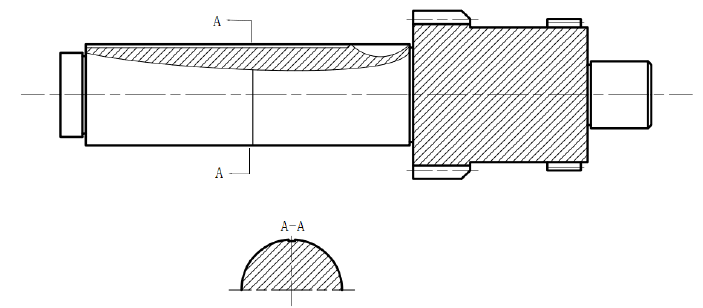
Figure 3. The engineering drawing of the workpiece. Table 2. Processing information.